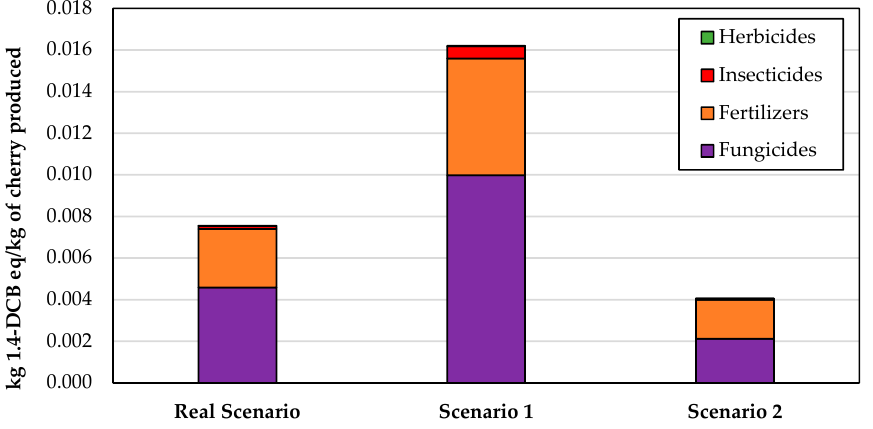
Figure 4. The freshwater ecotoxicity Indicator for the FU of 1 kg of produced cherry